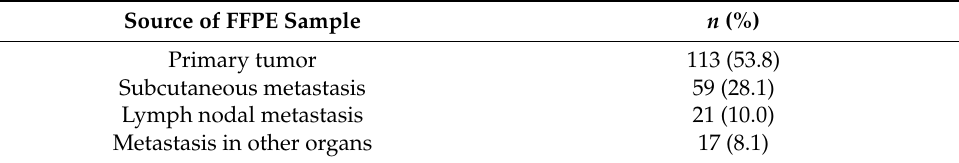
Table 2. Origin of tumor tissue samples from patients.